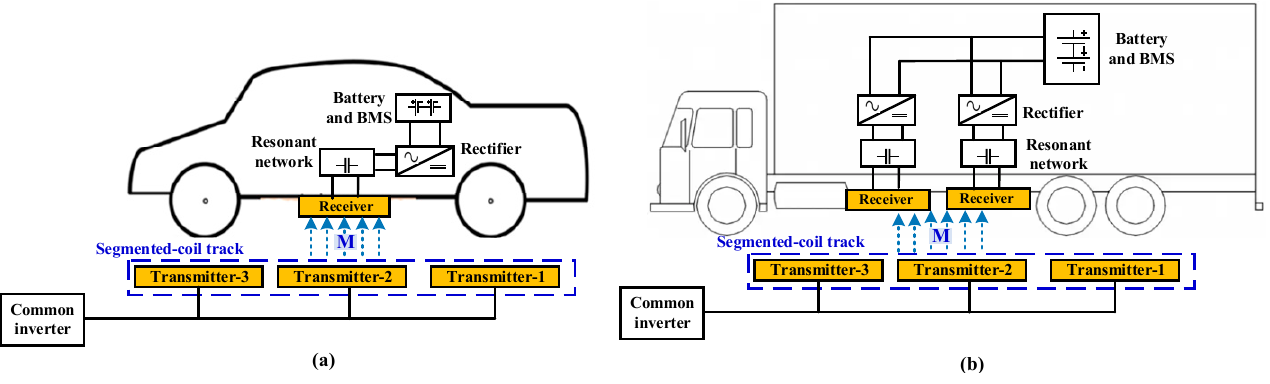
Figure 11. Implementation of receiver pad in DIPT system: ( a ) single pad and ( b ) multiple pads.